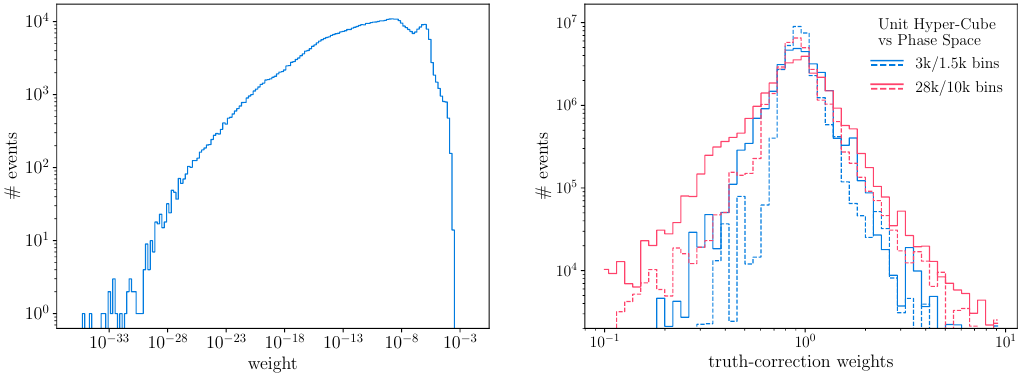
Figure 4: Left: Weight distribution for 500k weighted training events. Right: Truth- correction weights for 30M uwGAN events on the unit hyper-cube (solid) and the phase space parametrization of Eq.(17) (dashed) for 2k (blue) and 14k (red) bins in